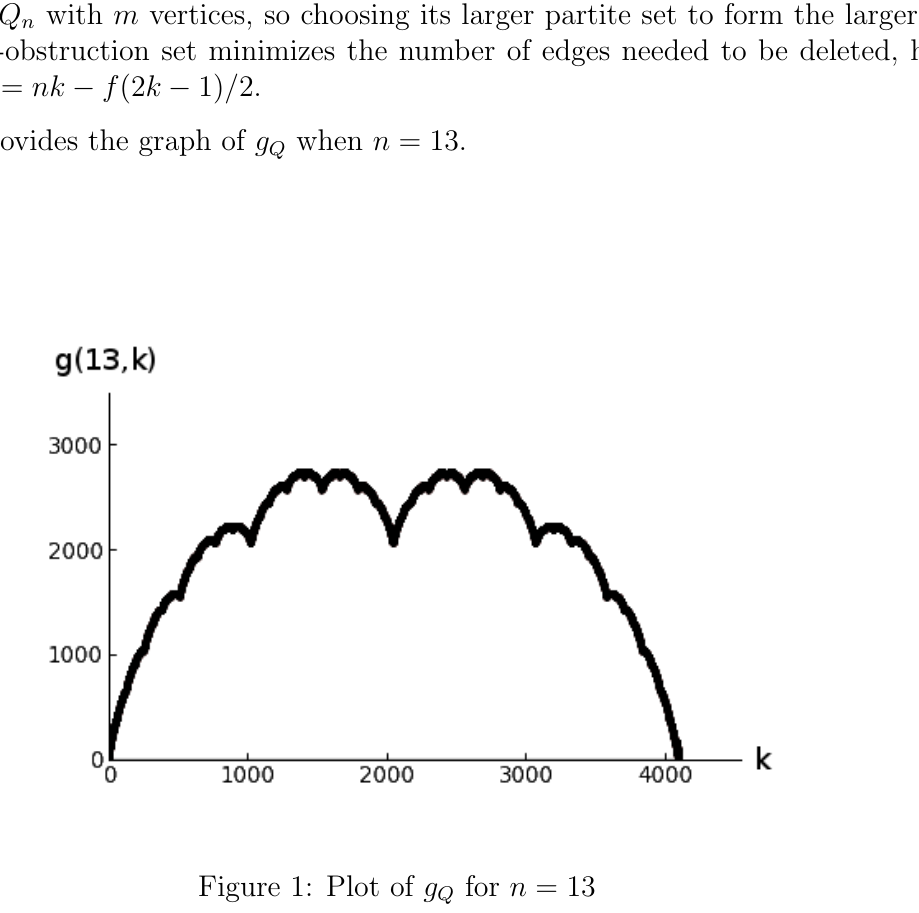
Figure 1: Plot of g